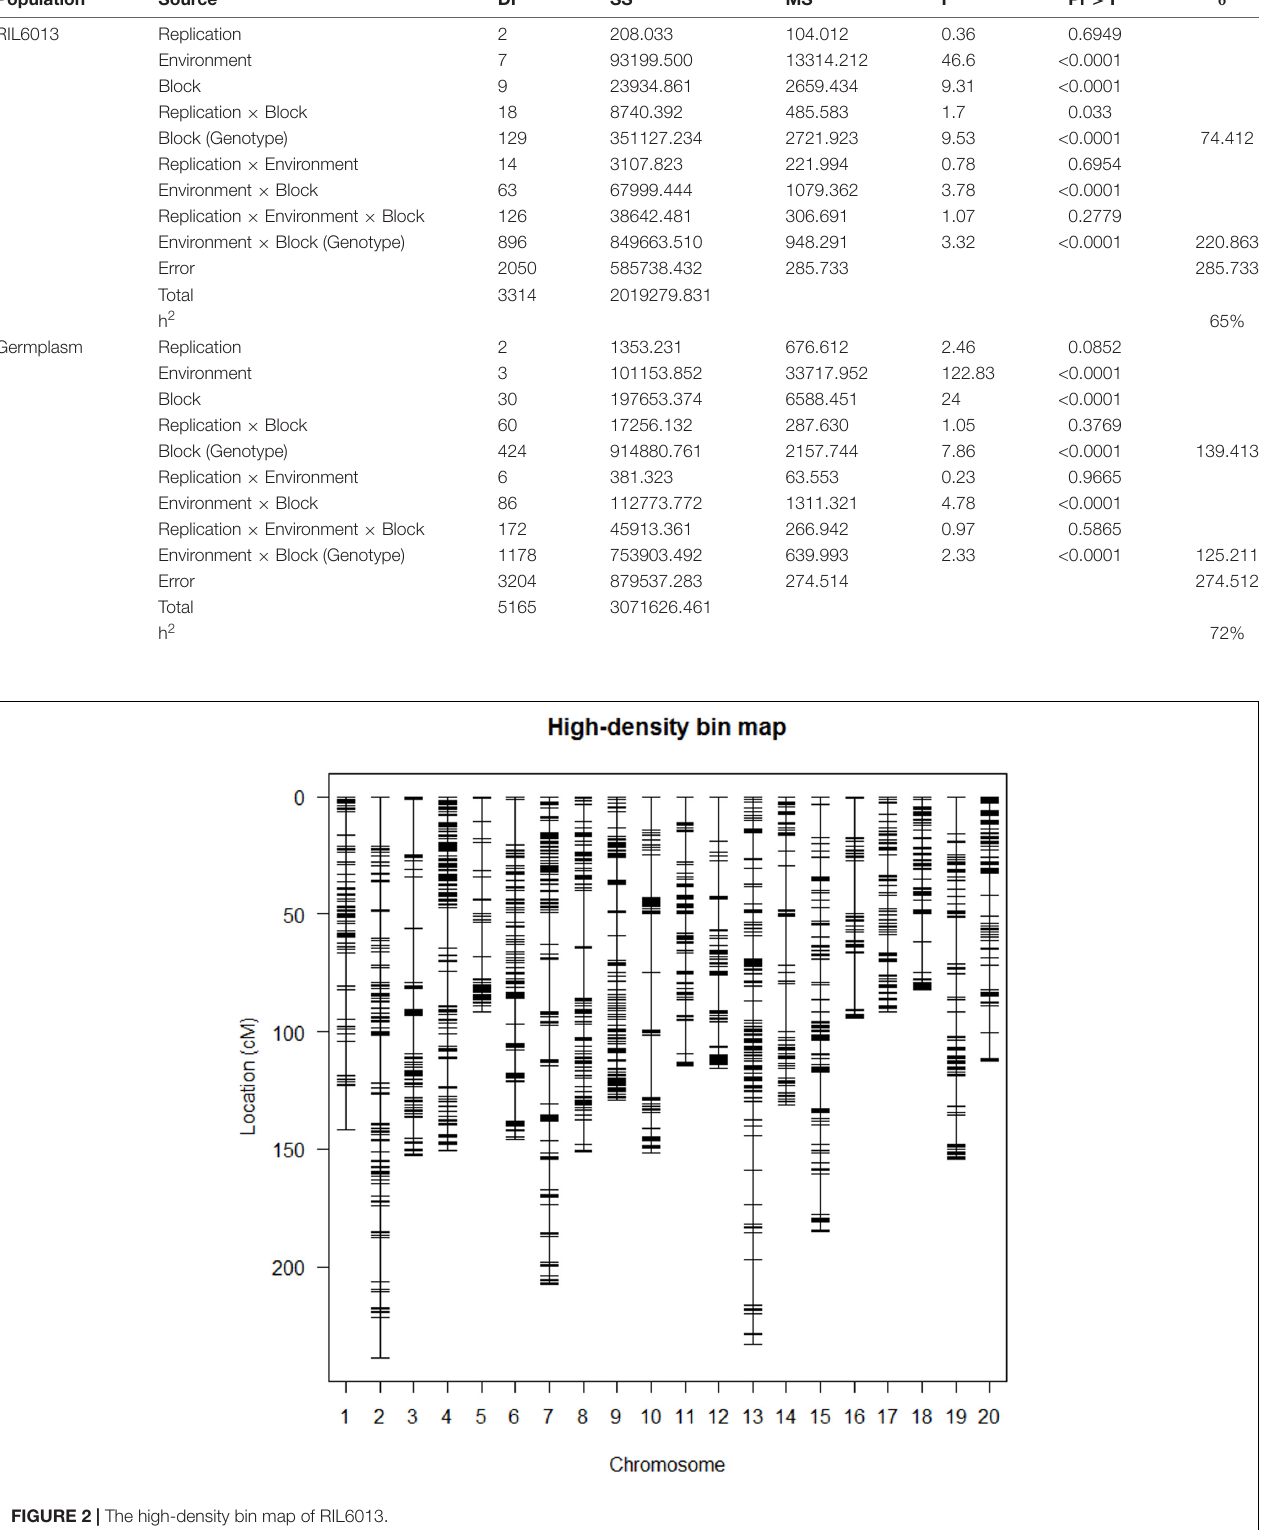
FIGURE 2 | The high-density bin map of